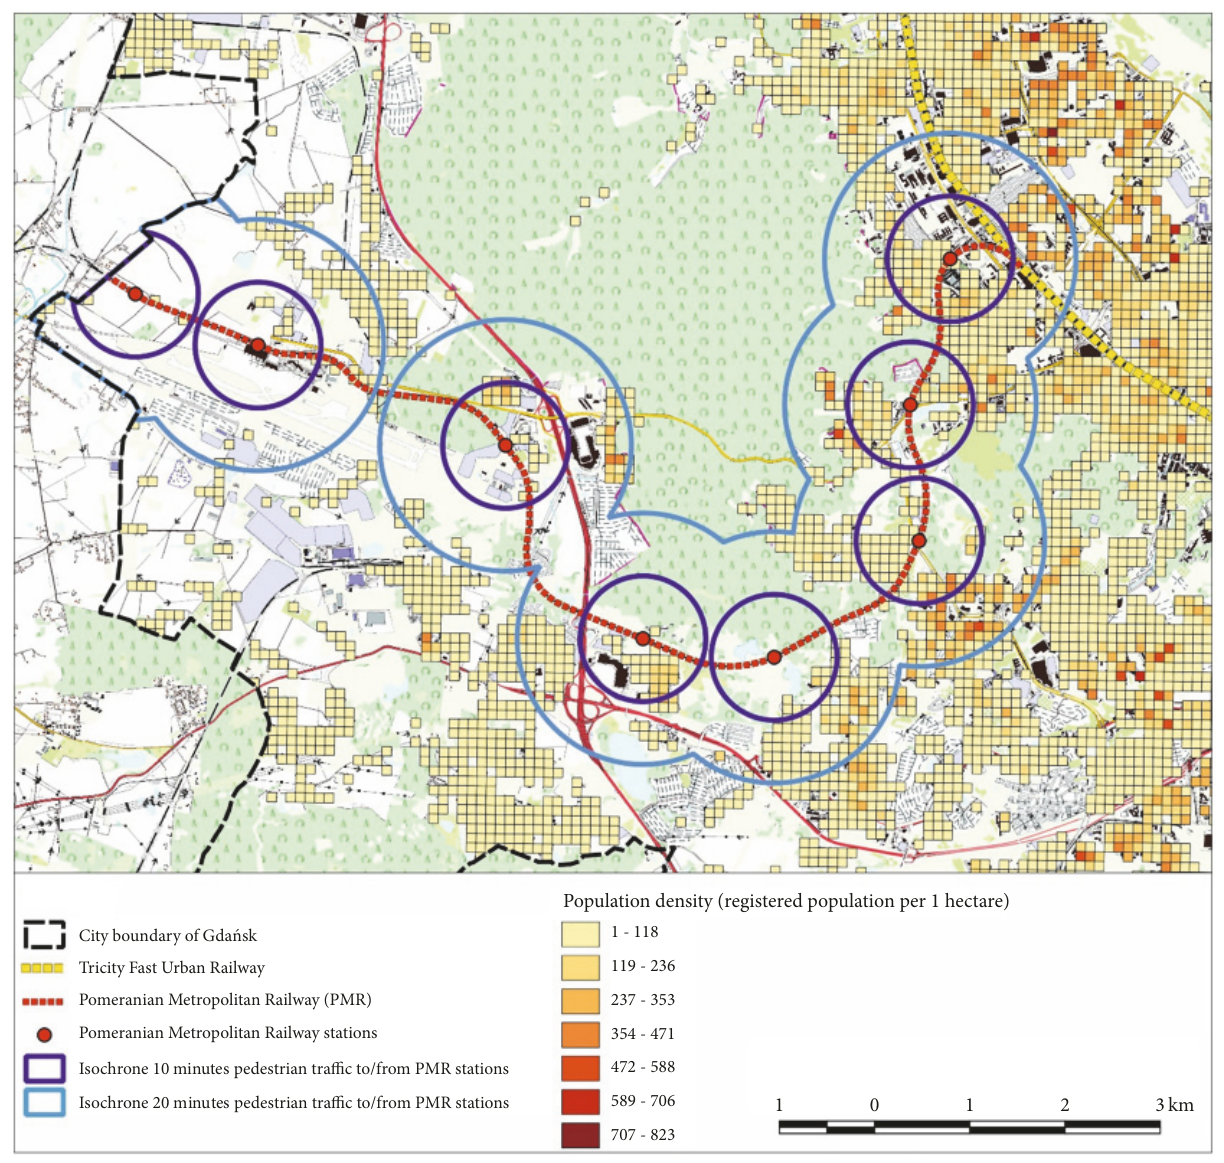
Figure 5: Population density per 1 ha in the zones of 10 and 20-min walking access to the PMR